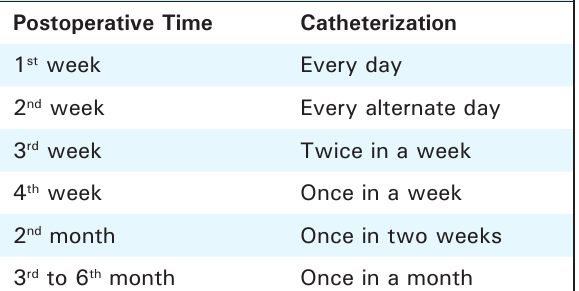
Table 1. CISC schedule after internal urethrotomy.